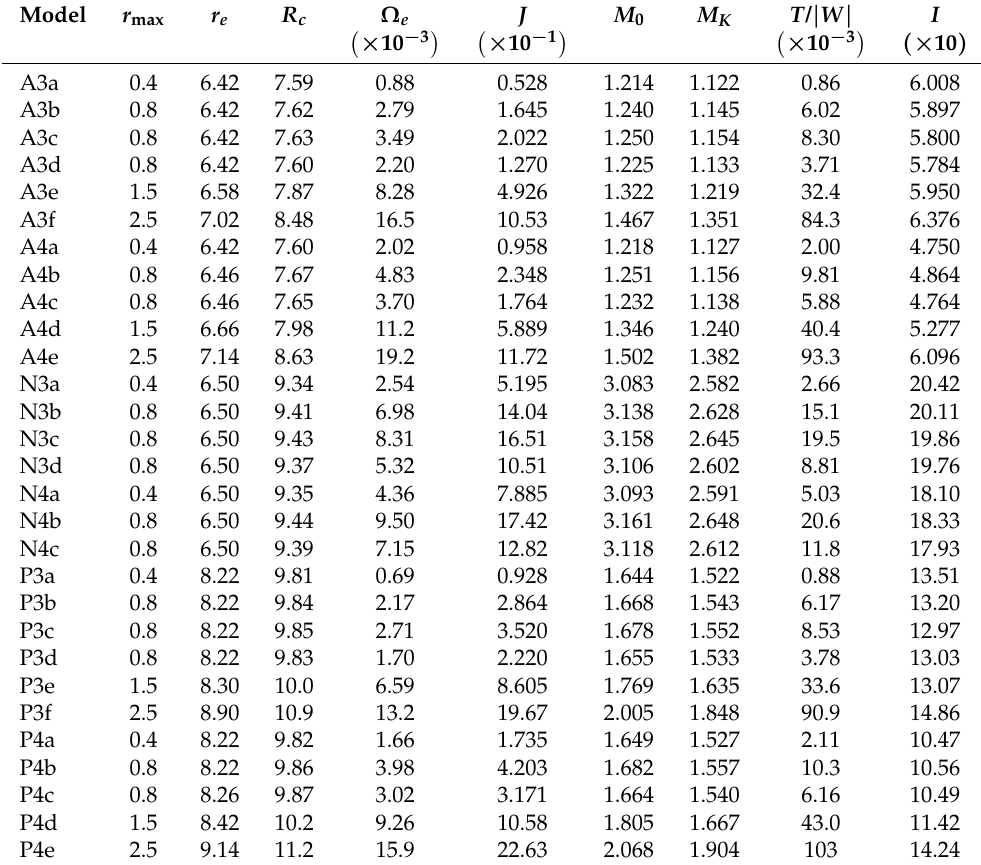
Table 1. Physical quantities for all models considered in this work. Listed quantities are (in ge- ometrized units) the radial position where the rotation rate reaches the maximum r max , the equatorial radius r e , the circumferential radius R c , the equatorial rotation rate Ω e , the angular momentum J , the rest and Komar masses M 0 and M K , the kinetic-to-gravitational ratio T / , and the moment of W | | inertia I . Models A are computed using the APR4 EoS, models N are computed using the NL3 ωρ EoS, and models P are computed using the polytropic EoS p = K ρ Γ with K = 110 and Γ = 2. The number in the model name refers to the Ury¯u law: models 3 are computed using the Uryu3 law with p = 3/2 (except for models 3c, computed with p = 1), while models 4 are computed using the Uryu4 law with ( p , q ) = ( 1,3 ) . All models are computed with λ = 2 (except for models 3d and 4c computed with λ = 1.5), and have a central density ρ c = 1.28 10 − 3 and a central rotation rate Ω c = 2.22 10 − 2 × ×